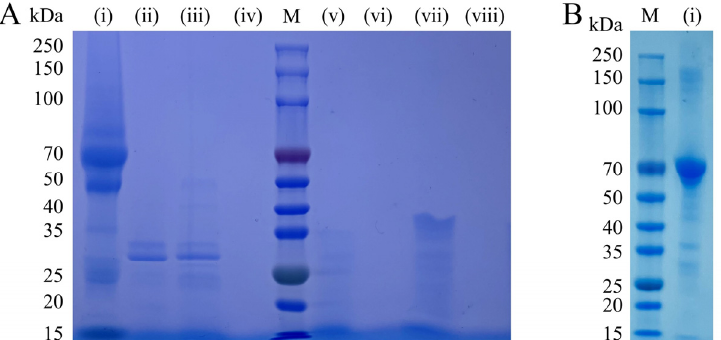
Figure 3. X-ray photoelectron spectroscopy of dirty cloth before and after washing with different proteases. ( A ) Protein-fouling cloth. ( B ) Blood-dirty cloth.